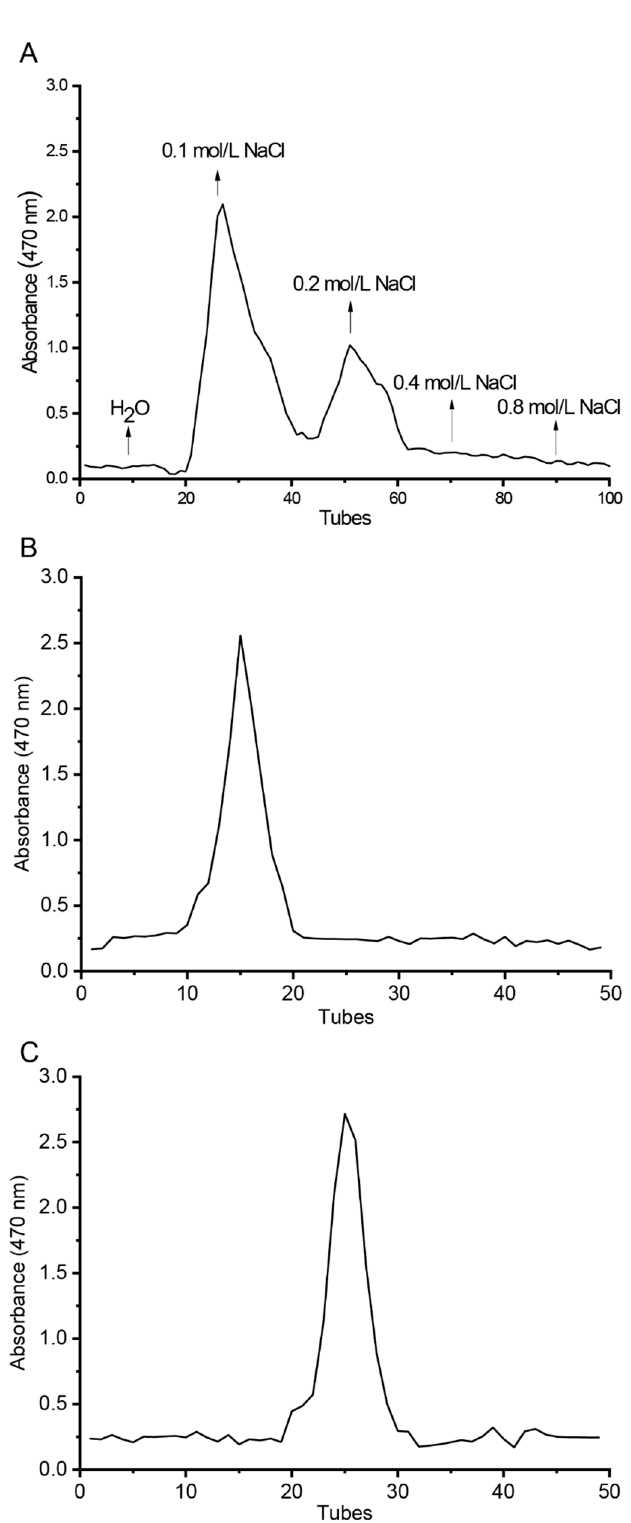
Figure 1. DEAE-52 elution curve of the CTLP ( A ), elution patterns of CTLP-1 ( B ), and CTLP-2 ( C ) on Sephadex